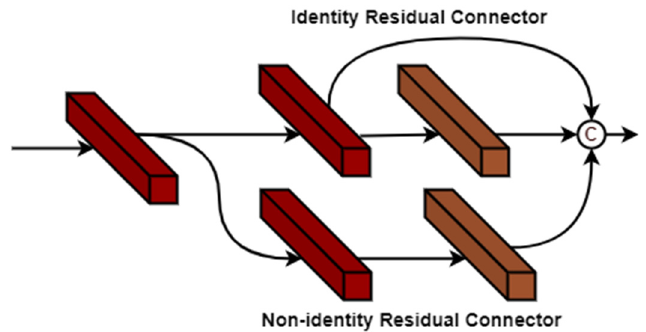
Figure 4. Identity and non-identity residual network in a vanilla Genoblock.